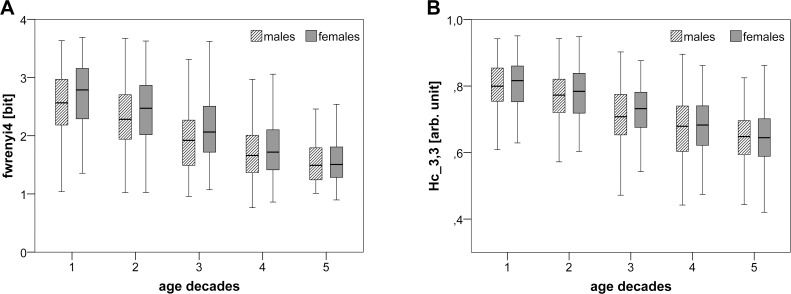
Box plots for fwrenyi4 and Hc
3,3 for five investigated age decades divided by gender.The box plots show two selected HRV indices (A: fwrenyi4 (SD) and B: Hc
3,3 (CE)) for the five investigated age decades (1: 25–34, 2: 35–44, 3: 45–54, 4: 55–64 and 5: 65–74 years) and divided into males (black cross-striped boxes) and females (white boxes). The boxes show the data between the 25th and 75 Percentile, the middle line represents the median.